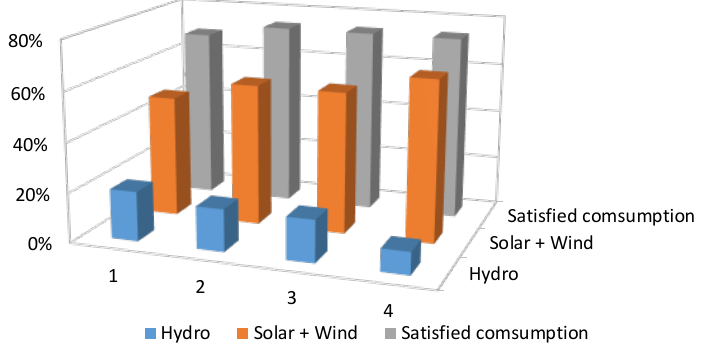
Figure 17. Total satisfied consumption through renewable energy (RE) in each scenario.